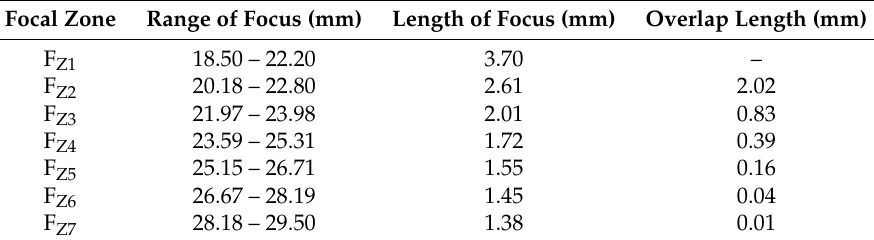
Table 3. The distribution of the focal zones of the MFP transducer.